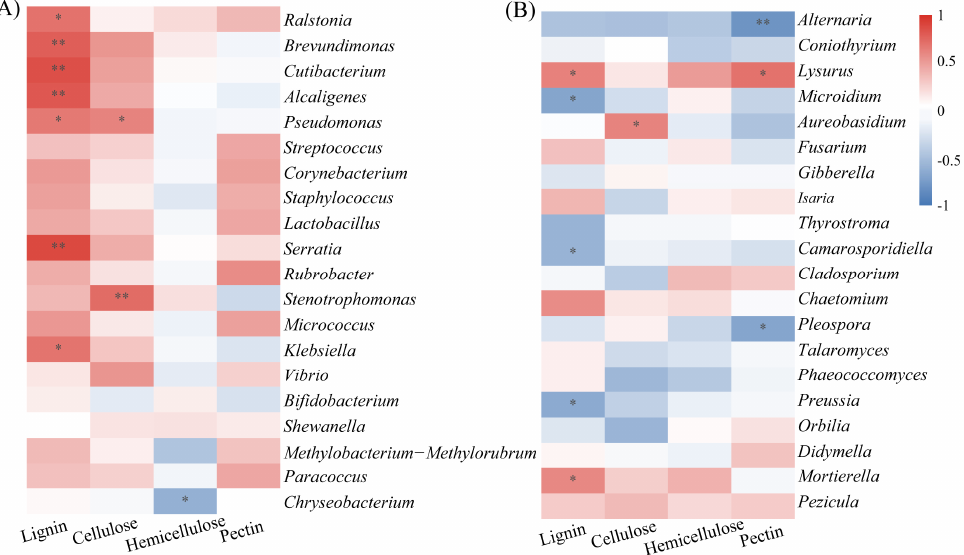
Figure 5. Spearman correlation between the top 20 genera of endophytic bacteria ( A ) and fungi ( B ) with lignification indices in young and mature branches of Nitraria tangutorum . (* p < 0.05, ** p < 0.01). 3.4. Co-Occurrence Network of the Endophytic Microorganism in YB and MB of N. tangutorum Agronomy 2023 , 13 , 90 The relationship between endophytic bacteria and fungi in YB and MB was further explored using the same module correlation network analysis, and it was found that there were fifteen modules in young branches and six modules in mature branches. There were more positive correlations in young branches. Compared to mature branches, fungi played a more important role in young branches, and the number of fungi increased from 27 (mature branches) to 54 (young branches), whereas the number of bacteria increased from 12 mature branches to 19 (young branches) (Figure 6, Table 1).